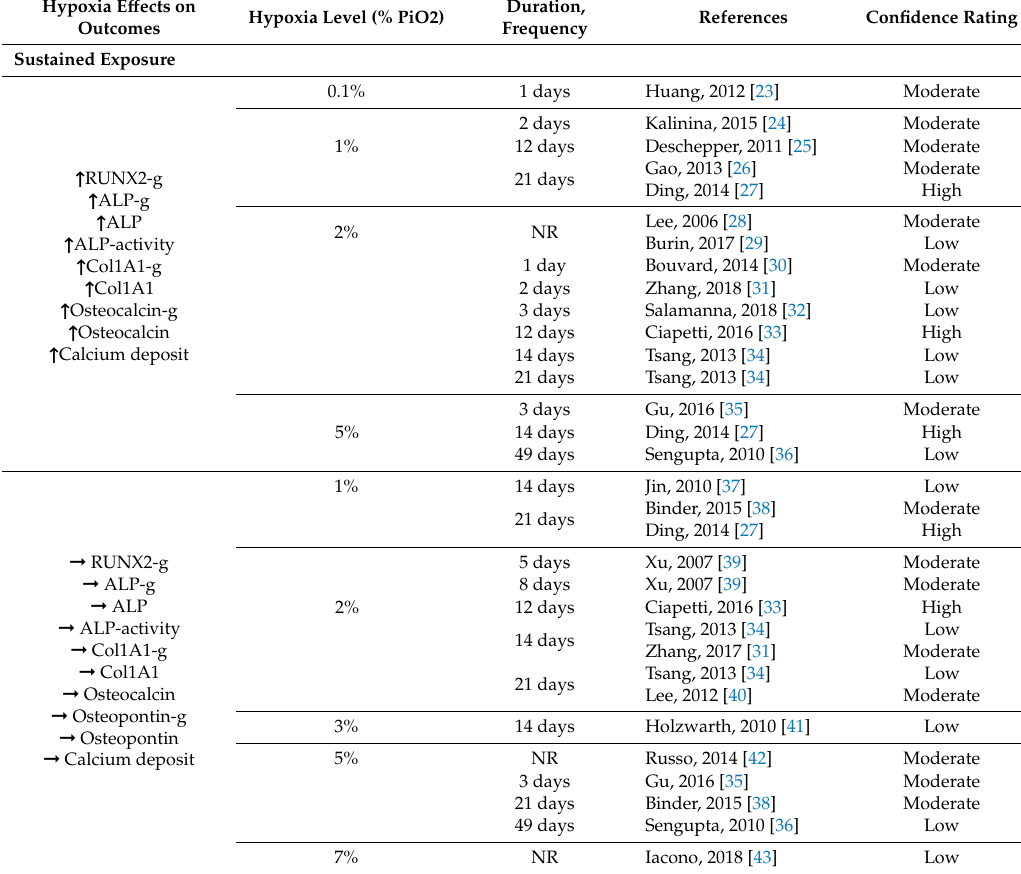
Table 1. Experimental details of in vitro studies included in this